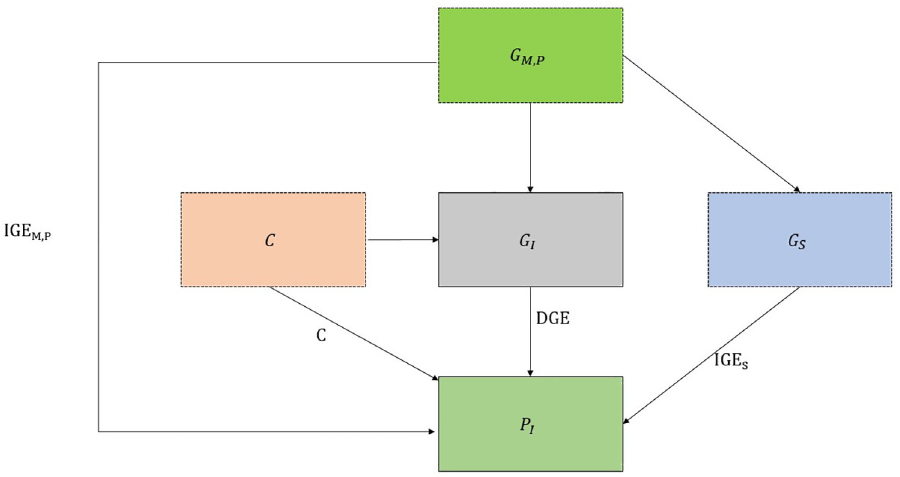
Fig 1. Sources of association between genotypes and phenotypes. The association between an individual’s genotype (G I ) and a phenotype (P I ) will capture the following: 1) direct genetic effects (DGE) of inheriting a variant or a correlated variant. 2) indirect genetic effects (IGE M,P,S ) of parental (maternal/paternal G M,P ) and sibling genotypes (G S ) on P I via the shared environment because of the correlations between G I , G M,P and G S . 3) Confounding factors (C) such as population stratification and assortative mating which confound the associations between genetic variants and phenotypes. If an individual has no siblings (or is raised apart from their siblings) then the G I , P I association cannot, by definition, be affected by indirect genetic effects of siblings. Therefore, indirect genetic effects of siblings are a possible explanation for heterogeneity in genetic associations between singletons and non-singletons. Note that this figure features several simplifications such as maternal and paternal indirect genetic effects being consistent and no paths between confounding factors and parental or sibling